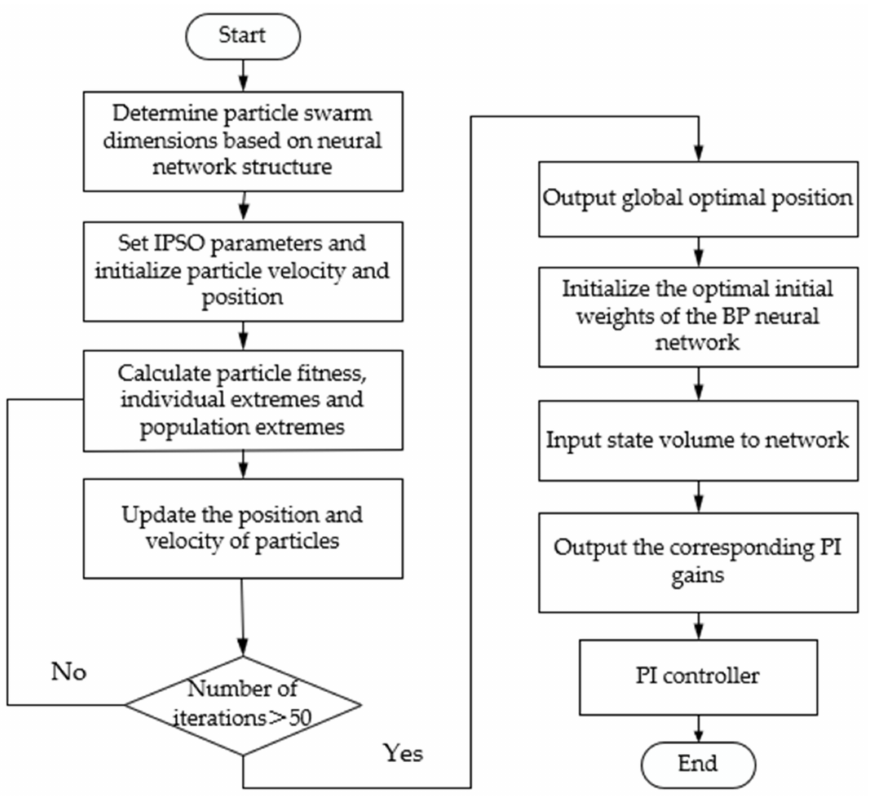
Figure 4. IPSO algorithm for optimizing neural network